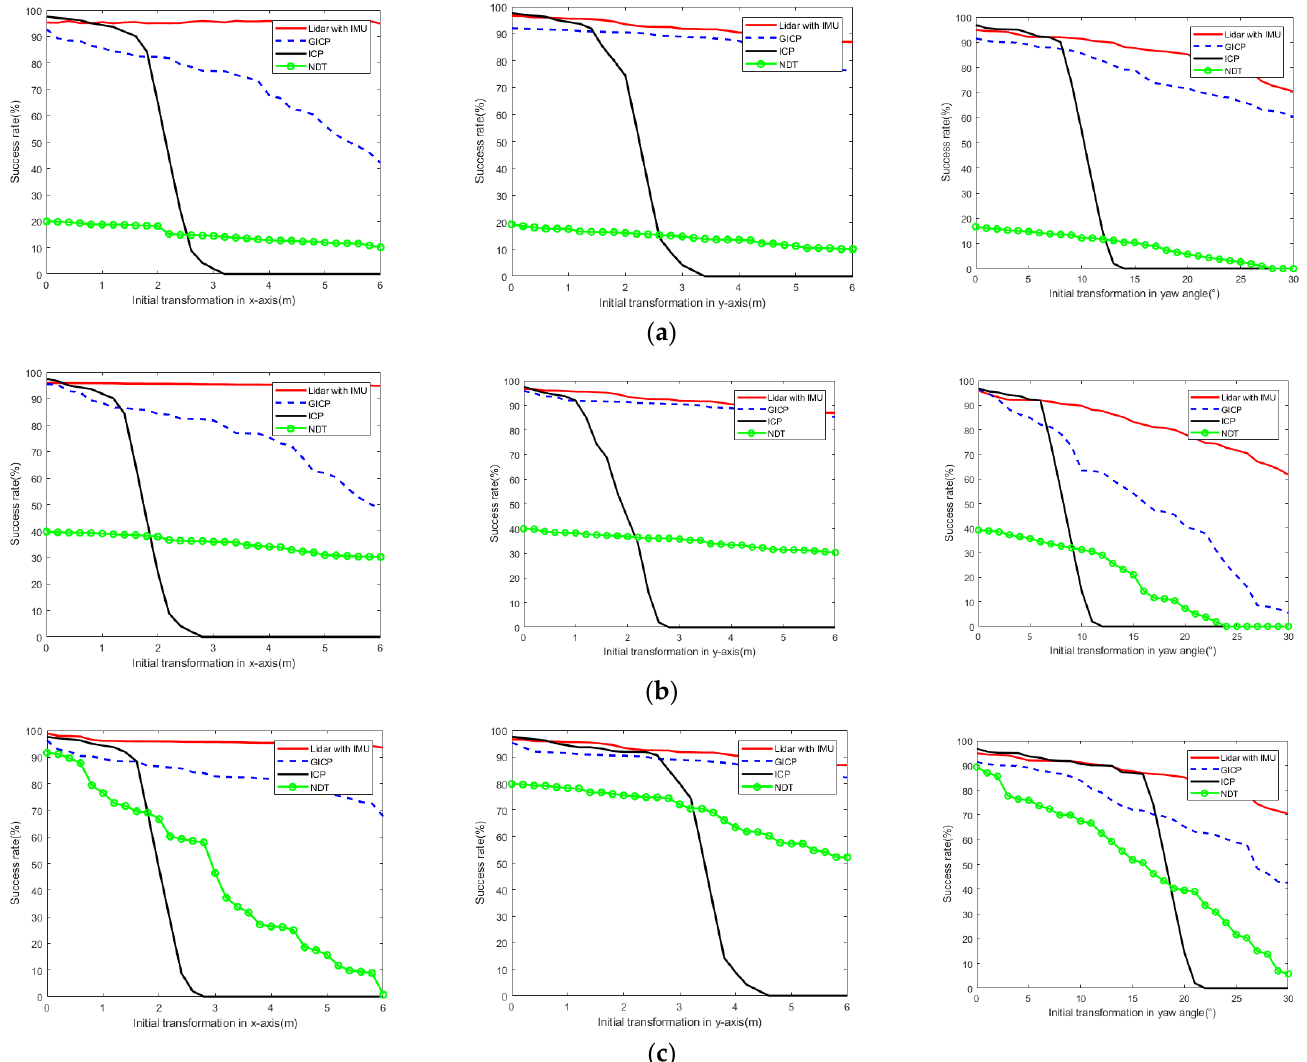
Figure 10. Success rate of different point cloud registration algorithms; ( left ) initial transformation in x-axis direction, ( middle ) y-axis direction, ( right ) initial yaw angle. ( a ) KITTI datasets; ( b ) Park datasets; ( c ) Coal mine roadway datasets.